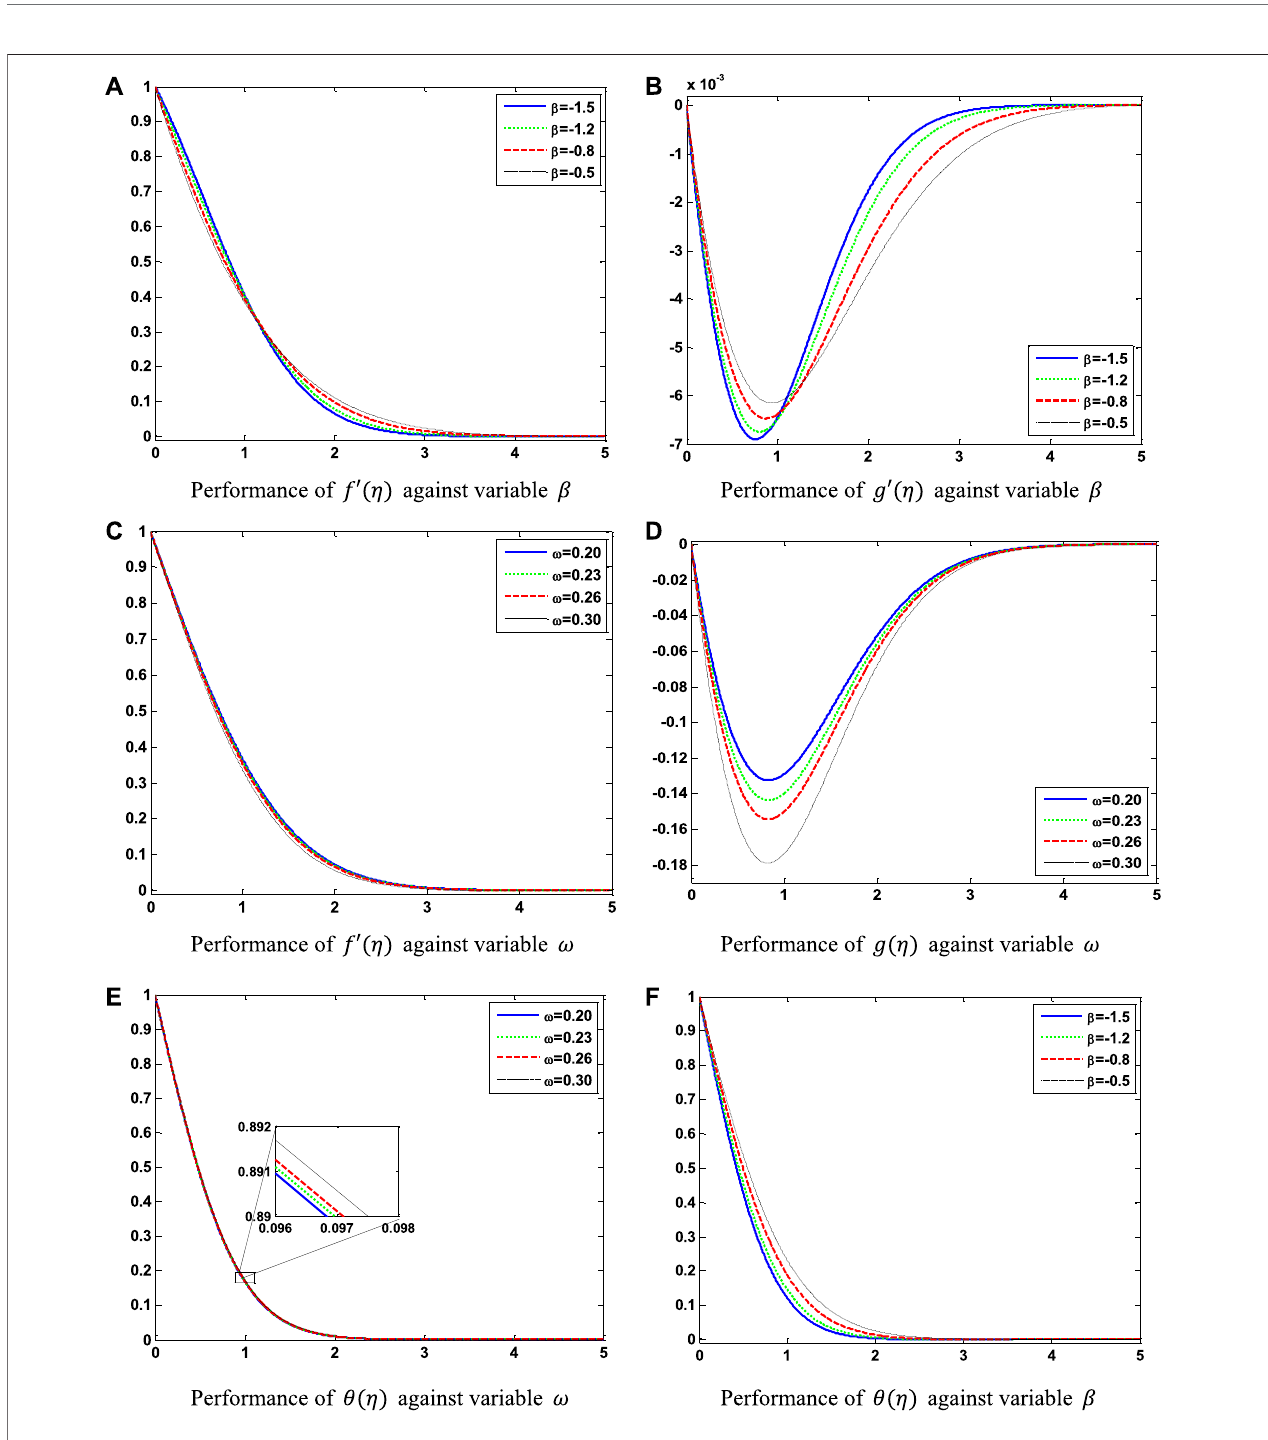
FIGURE 3 | Variation of velocity and temperature pro fi le against β , ω , and, Rd .